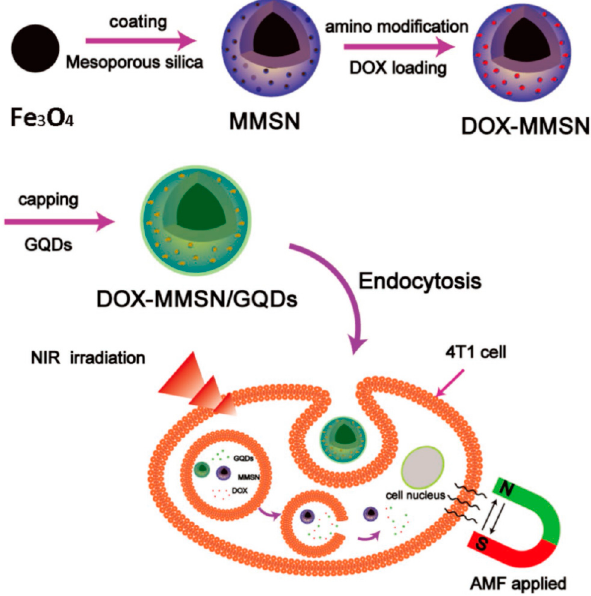
Figure 4. Schematic illustration of the preparation of DOX- magnetic mesoporous silica nanoparticles (MMSN)/GQD nanohybrids and its controlled drug release and photothermal therapy mechanism. Reproduced with permission from [39]. Copyright Wiley-VCH, 2017.